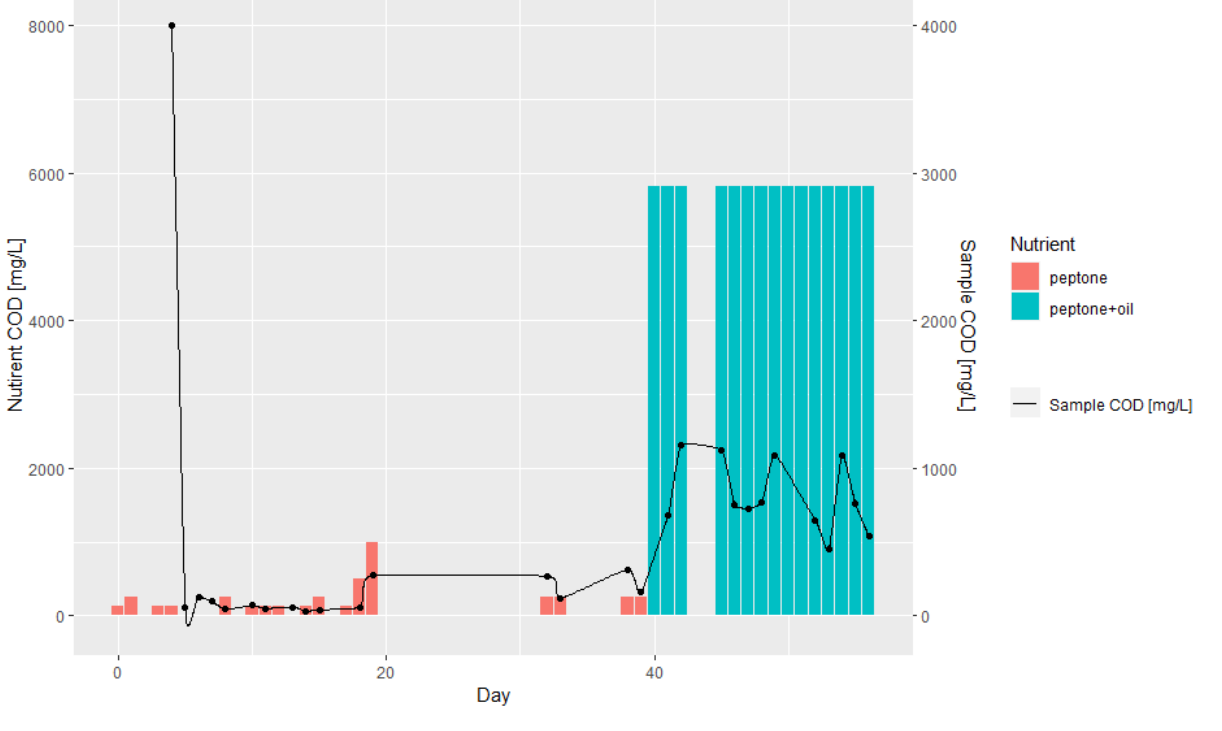
Figure 8. Relationship in time between chemical oxygen demand, medium and unfiltered sample from the continuous-flow bioreactor.